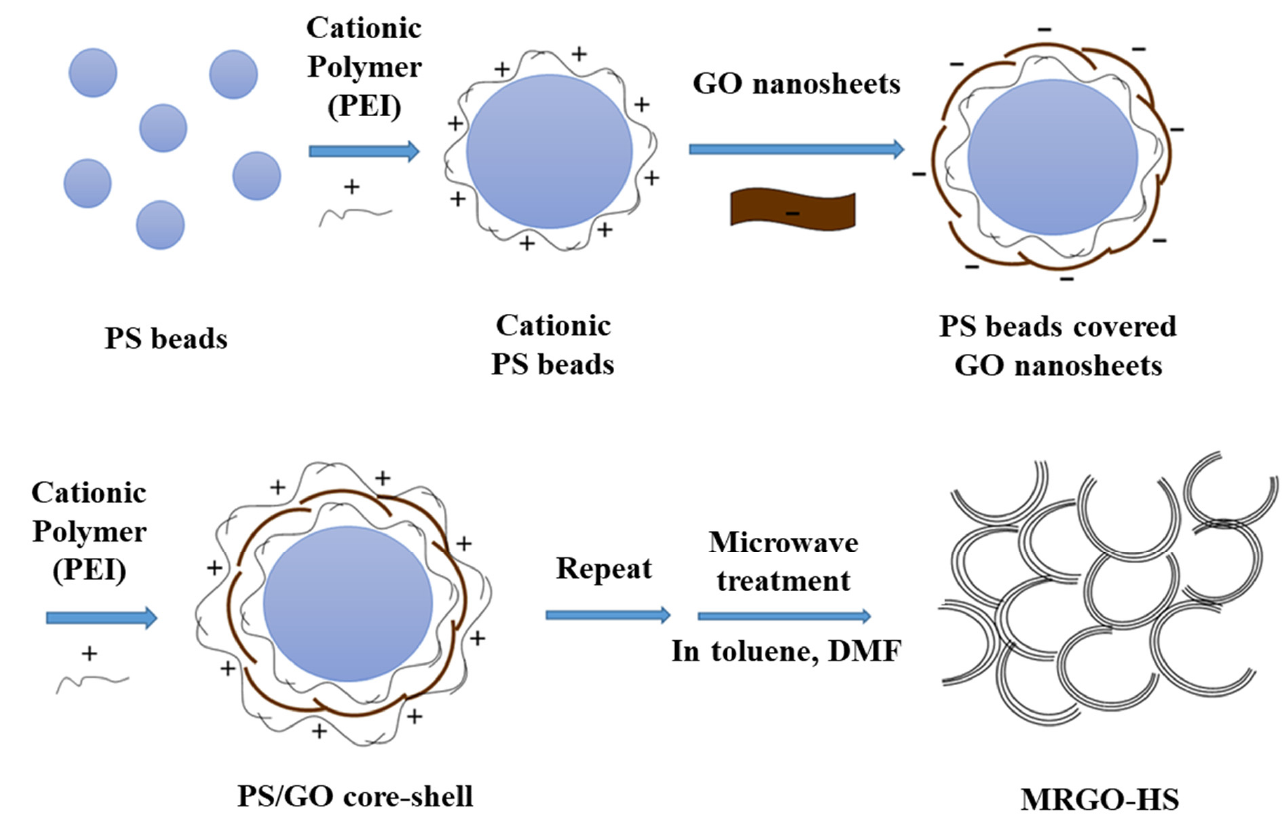
Figure 1. Schematic illustration of the MRGO-HS synthesis.